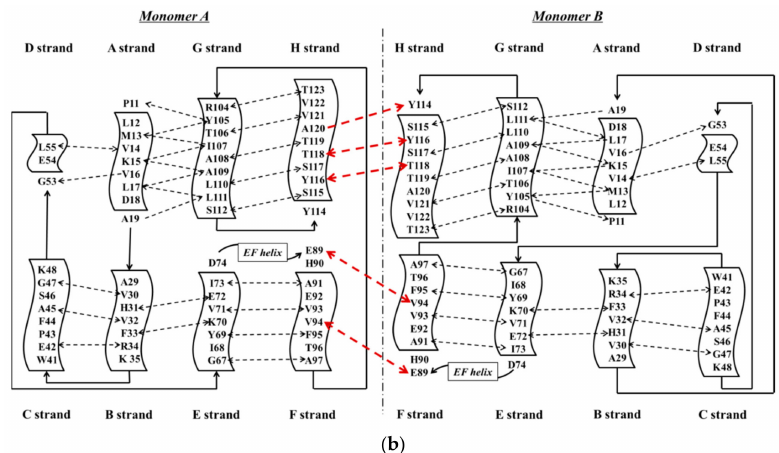
Figure 1. ( a ) 3-Dimensional structure of ATTRwt (PDBe ID code; 1BMZ [18]) in dimeric form; ( b ) Schematic diagram of hydrogen bonds in transthyretin and monomer–monomer’s hydrogen bonds. Arrowhead indicates acceptor, the tail indicates donor. In acidic condition, hydrogen bonds will be broken and destabilized.